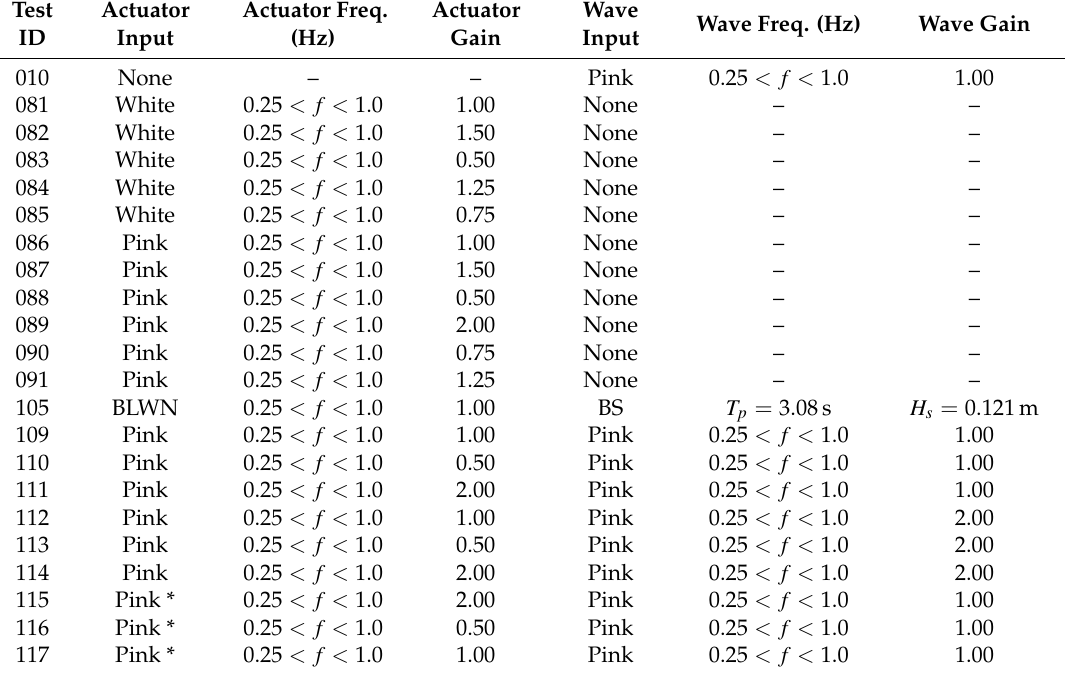
Table 3. Experimental datasets utilized in this study. For experiment 105, both the wave train and actuator input are non-periodic: in particular, the actuator input is a band-limited white noise (BLWN) and the wave spectra is Bretschneider (BS) (* indicates reseeded